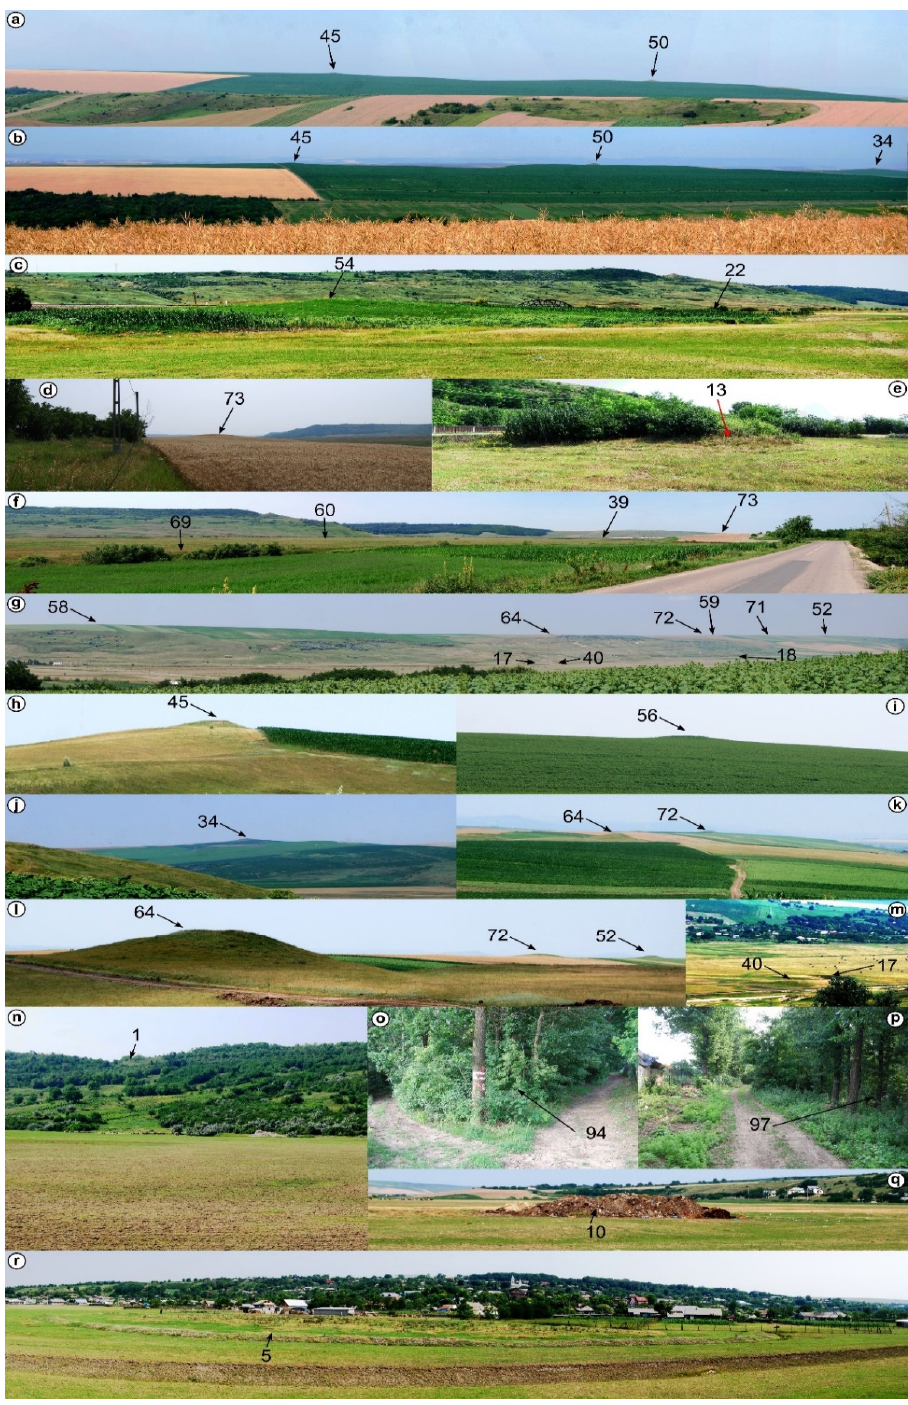
Figure 4. Field photos for verification (the numbers are the burial mound IDs from Figure 1): ( a )—burial mounds 45 and 50 as seen from burial mound 36; ( b )—burial mounds 34, 50 and 45 as seen from burial mound 46; ( c )—burial mounds 22 and 54; ( d )—burial mound 73; ( e )—burial mound 13; ( f )—burial mounds 39, 60, 69 and 73; ( g )—burial mounds 40, 52, 58, 59, 64, 71 and 72 and mounds 17 and 18; ( h )—burial mound 45 seen from the south; ( i )—burial mounds 56; ( j )—burial mound 34 seen from burial mound 62; ( k )—burial mounds 64 and 72 seen from burial mound 58; ( l )—burial mounds 64, 72 and 52; ( m )—burial mound 40 and mound 17; ( n )—landslide; ( o , p )—vegetation; ( q , r )—landfill. (a high-resolution version can be found at https://doi.org/10.6084/m9.figshare.11798625.v1)